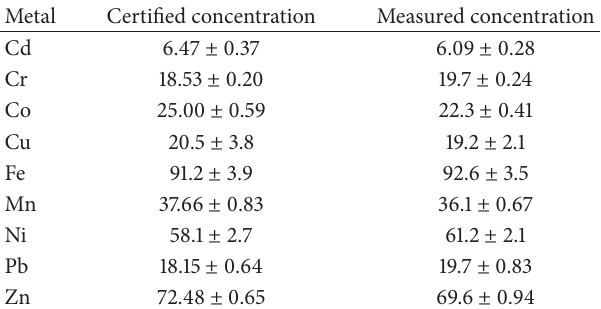
Table 1: Certified versus measured concentrations ( 𝜇 g/L) of trace metals in standard reference material (SRM